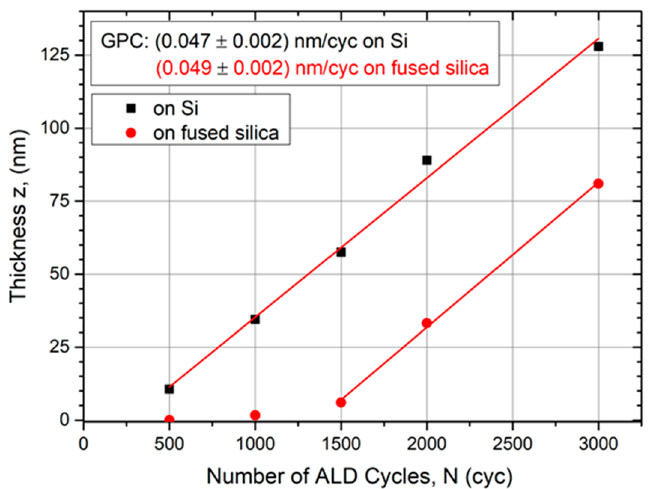
Figure 2. Evolution of Ru film thickness determined by XRR measurements as function of the number of ALD cycles on different substrates. After a nucleation delay, the growth rate per cycle (GPC) becomes constant for both substrate materials.